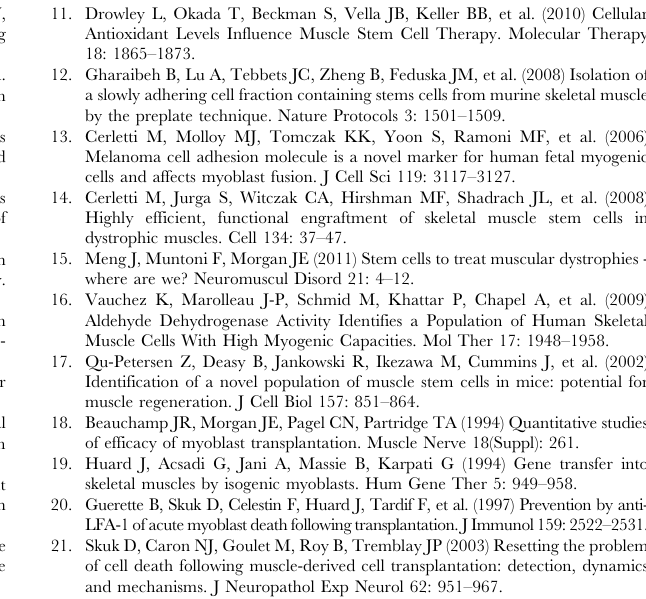
Table S1 Data summary of ALDH sorted populations isolated from skeletal